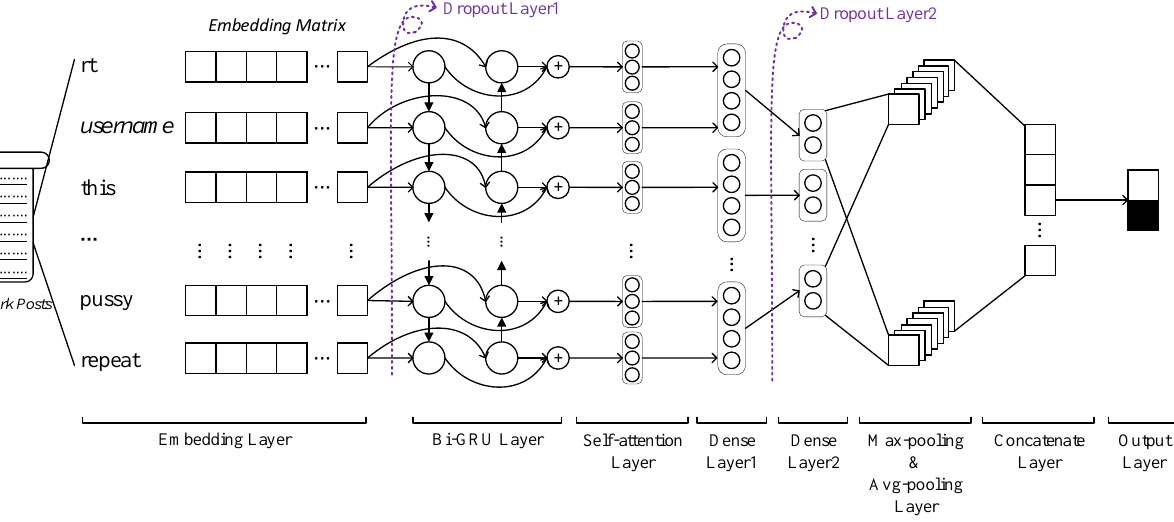
Figure 1. The architecture of proposed